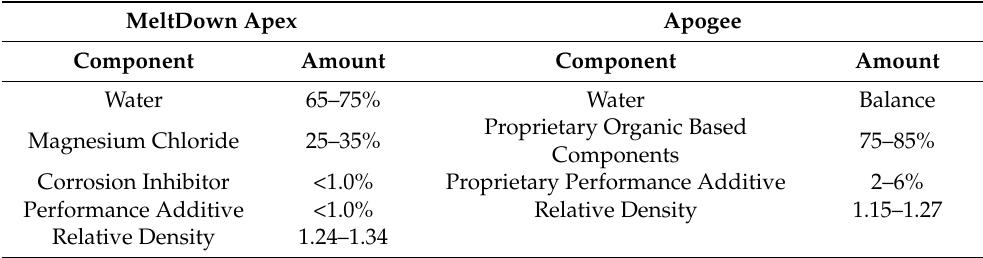
Table 2. Composition/information on ingredients (provided by EnviroTech Services, Inc., Greeley, CO,